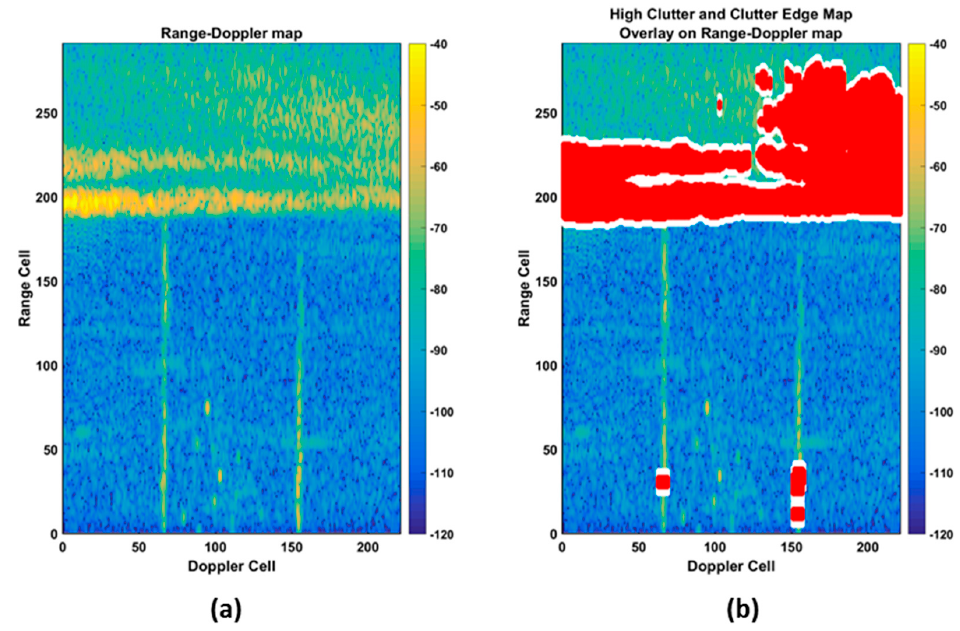
Figure 8. ( a ) Typical range–Doppler plane, with ( b ) high-clutter areas, and edges identified with a red and white overlay.